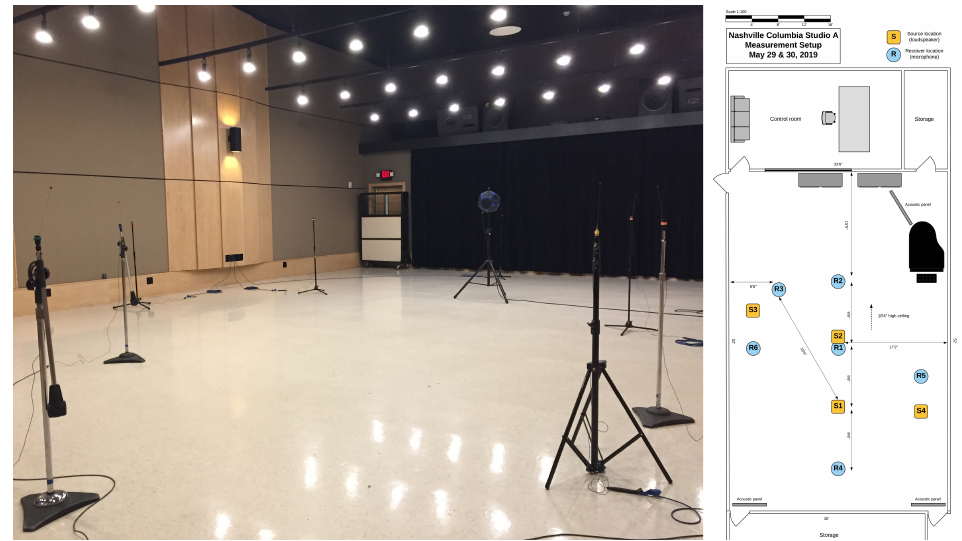
Figure 1. Columbia Studio A (Nashville, TN, USA): photo and schematic of aural heritage fieldwork configurations showing multiple acoustical source and receiver locations, iteratively measured using a variety of equipment and microphone configurations. Diagram by Doyuen Ko.